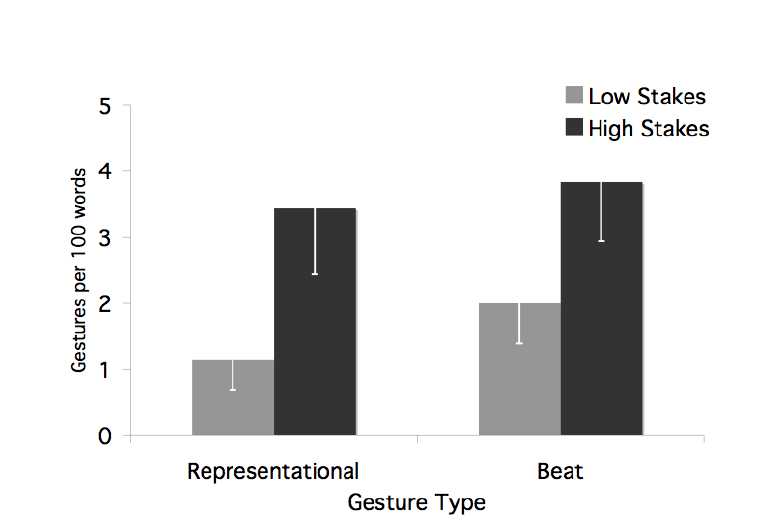
Figure 2. Number of representational and beat gestures produced per 100 words for the low and high stakes conditions ( n = 20). Error bars reflect standard error of the